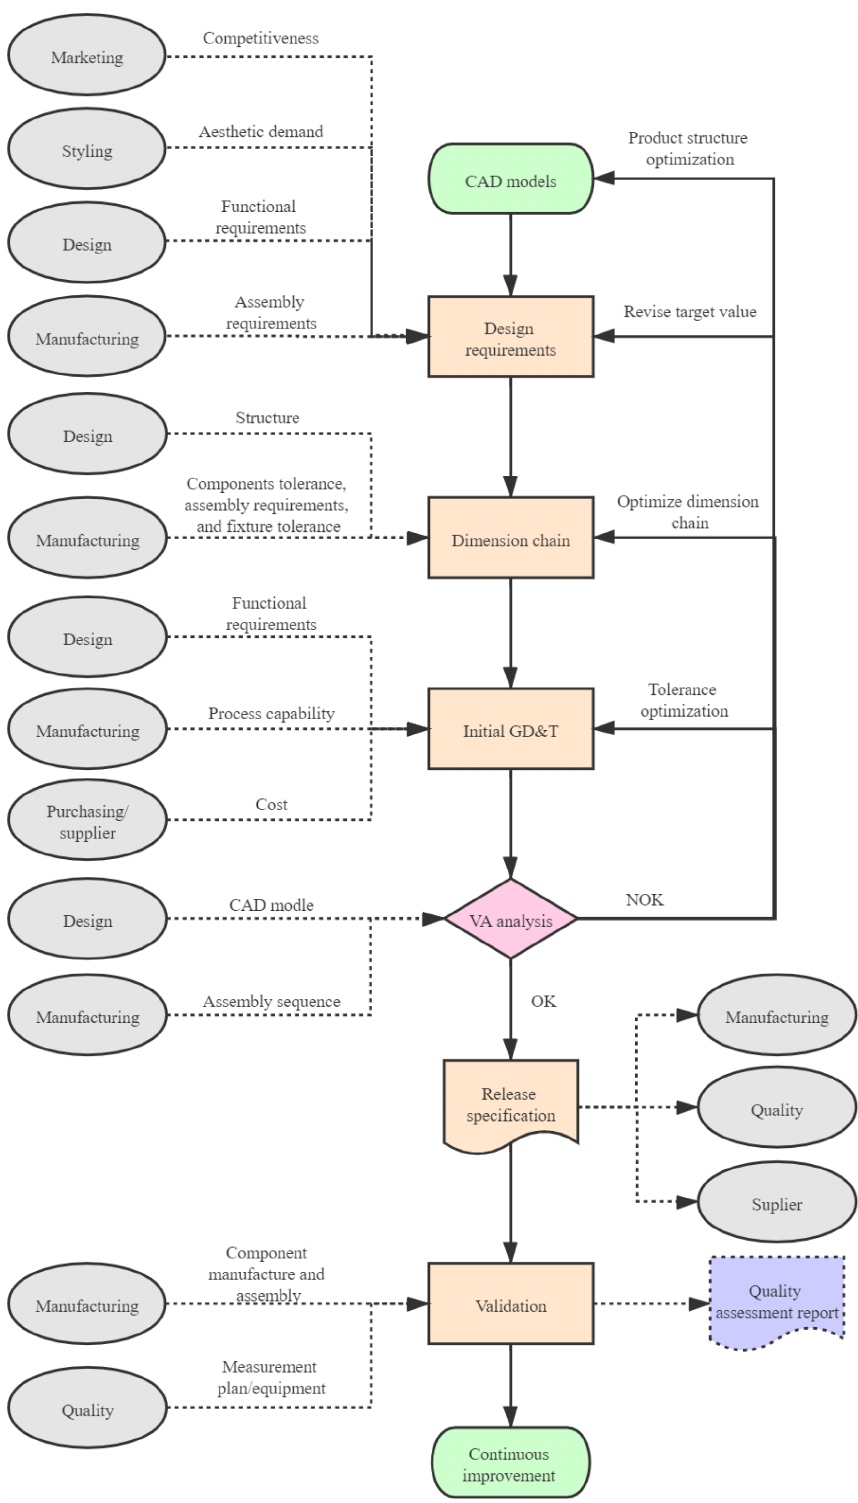
Figure 2. Framework of the concurrent tolerance design methodology.